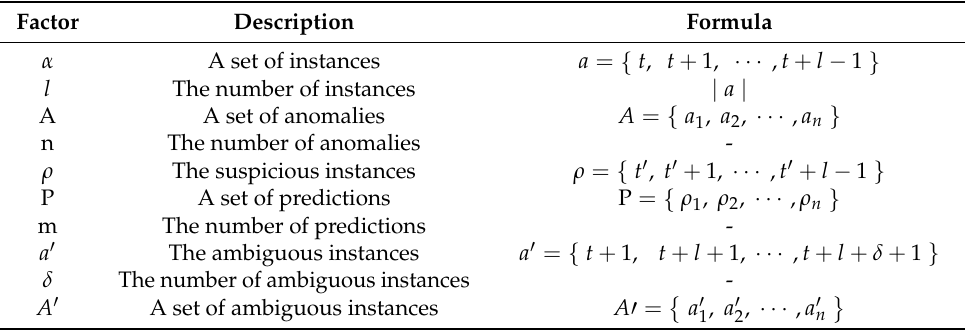
Table 3. Factors and formulas constituting the performance metrics TaP and